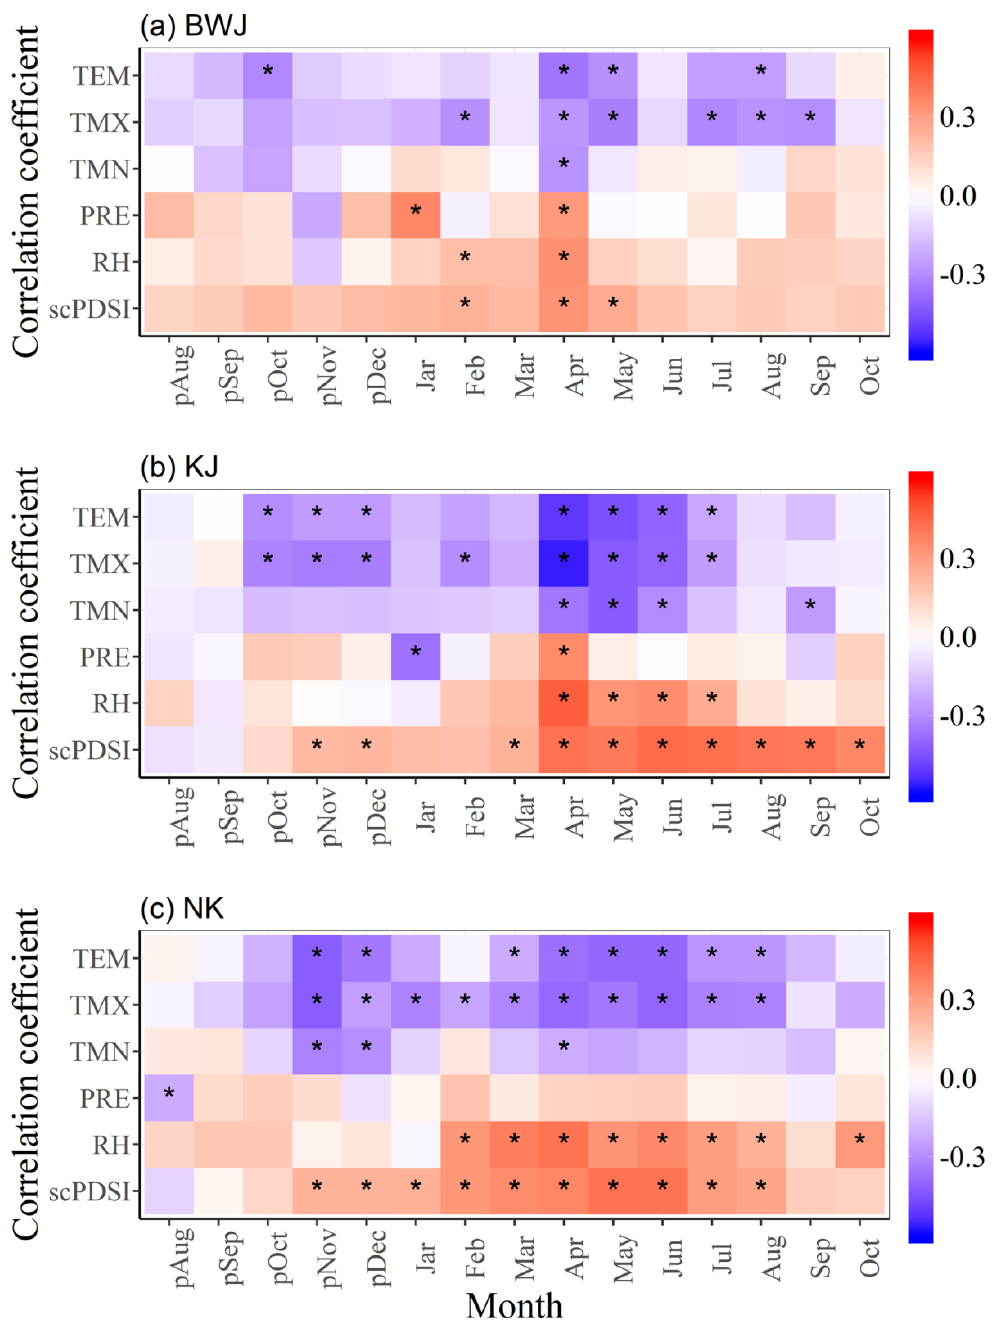
Figure 3. Correlation coefficients (bootstrapped) between tree-ring residual chronologies and climate data for the BWJ ( a ), KJ ( b ) and NK ( c ) sites in Thailand. Climate data include mean (TEM), maximum (TMX) and minimum temperature (TMN), precipitation (PRE), relative humidity (RH) and self-calibrated Palmer drought severity index (scPDSI). Correlations were calculated over the period 1951–2017 for a 15-month window from previous August to current October. Scale bars show the ranges of correlation coefficients; asterisks indicate significance at p < 0.05 level.